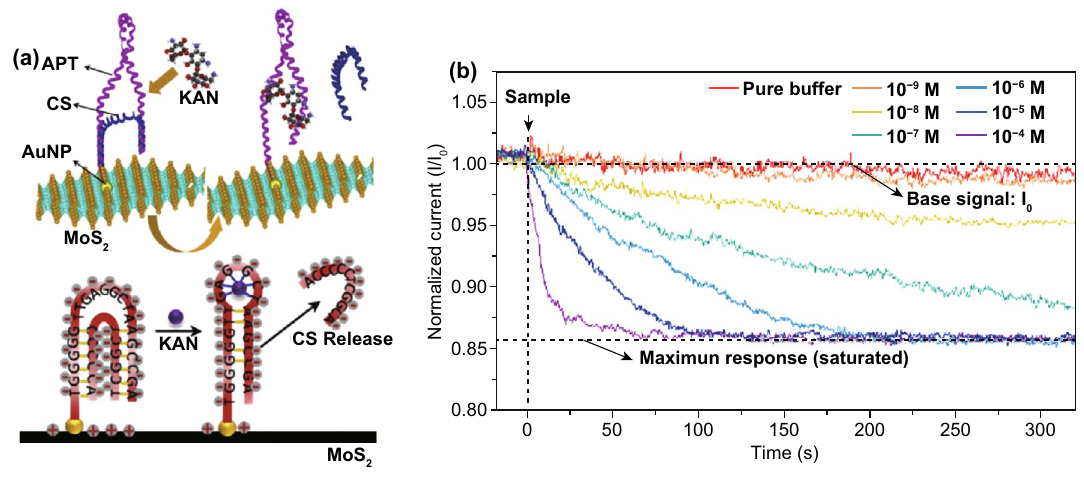
Fig. 7 2D TMDC FET sensor for non-ionic molecule detection. a Sensing mechanism of kanamycin sensing on MoS 2 FET platform. b Time- resolved responses for kanamycin at different concentrations. Reprinted with permission from Ref. [133], Copyright 2019,